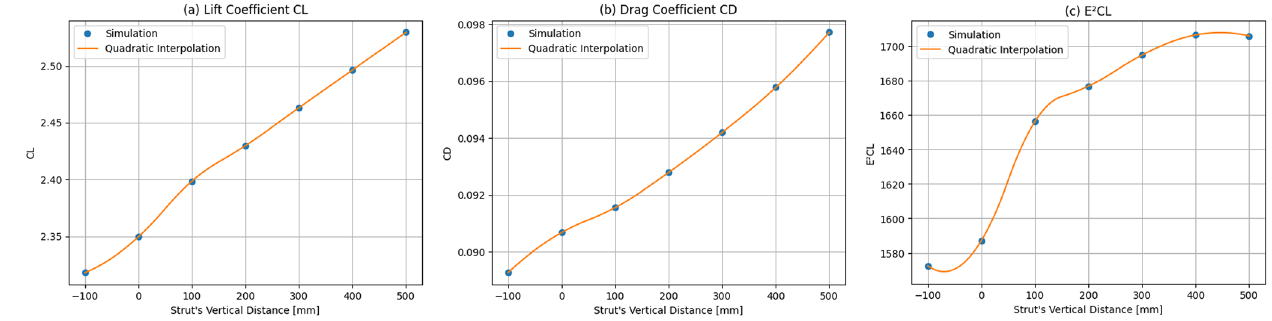
Figure 17. Effect of strut’s vertical distance on (a) C L , (b) C D and (c) E 2 C L